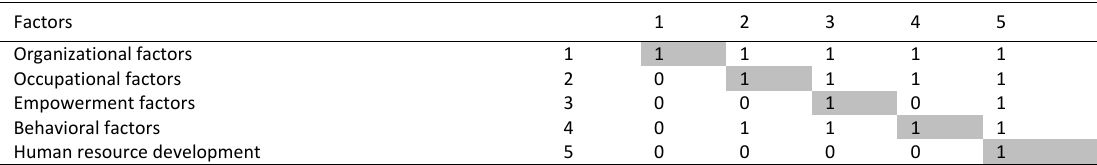
Table 6. The access matrix after adjustment